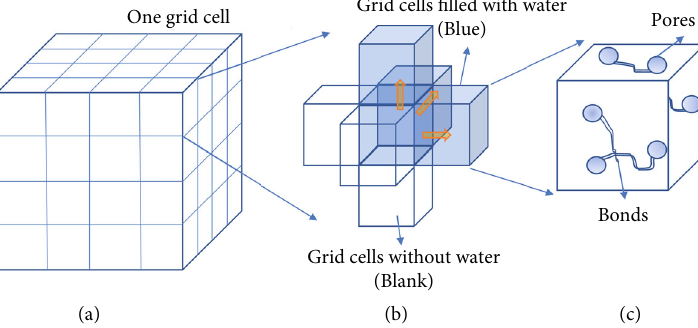
Figure 3: Construction of rock samples with grid cells: (a) Virtual cubic rock sample with grid cells. (b) Water moves from one grid cell to three stochastic directions in one step (between grid cells). (c) One grid cell with pores and bonds (void space connected with other